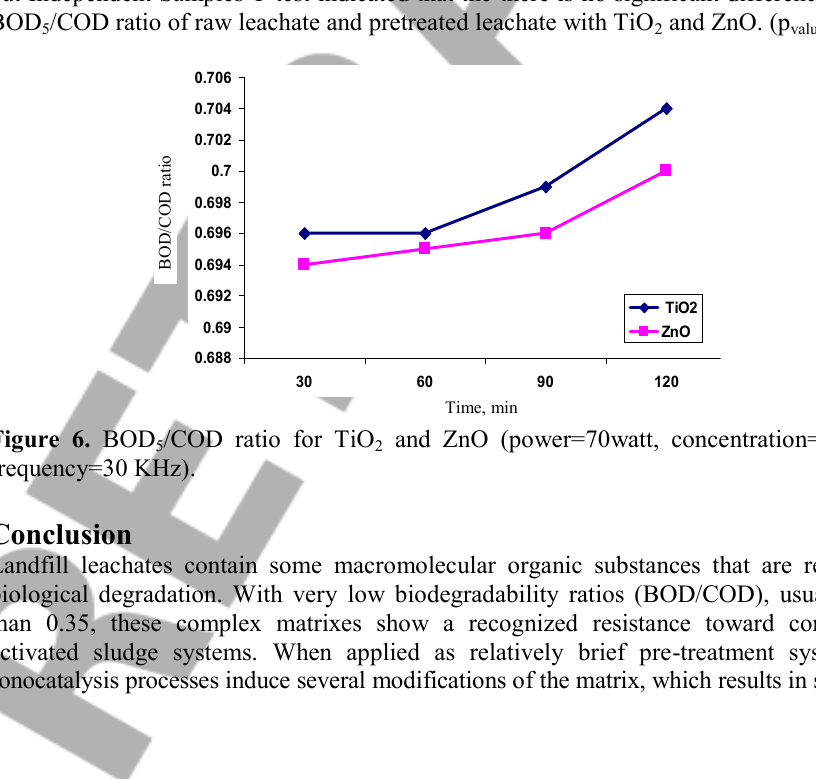
Figure 5. BOD/COD ratio for TiO 5 mg/L, frequency=30 KHz).